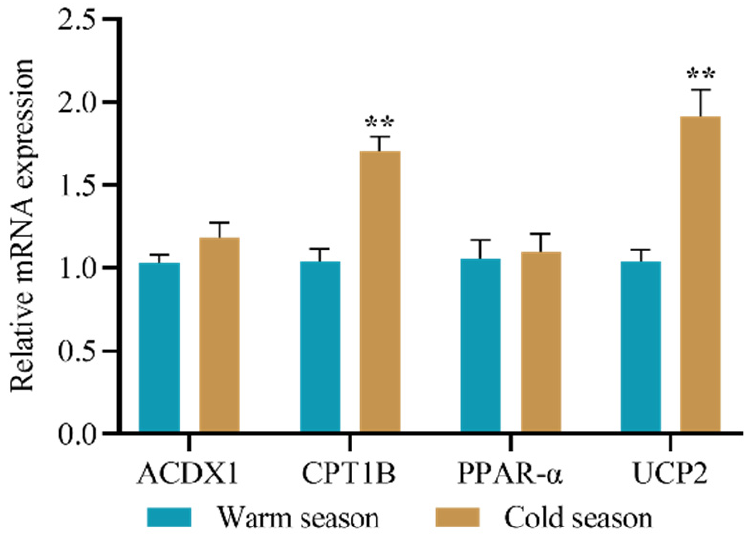
Figure 1. Changes in lipolytic and thermogenesis-related gene expression of livers in grazing Mon- golian sheep. Each bar represents the mean ± SEM; ** indicates a p value < 0.01.